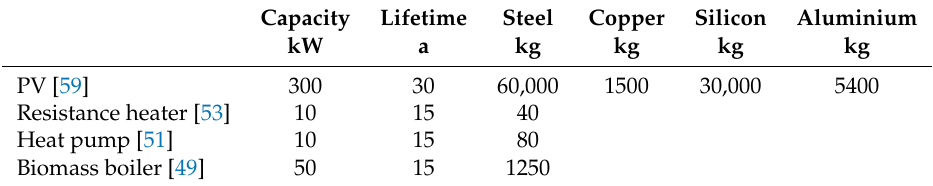
Table A4. Capacity, lifetime and material data for conversion units—part II.